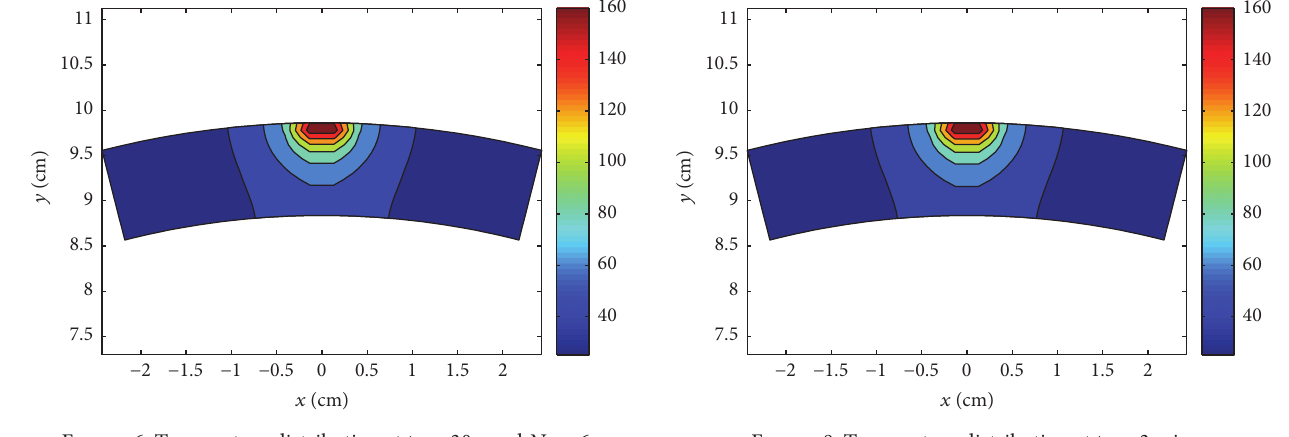
Figure 6: Temperature distribution at 𝑡 𝑓 = 30 s and 𝑁 1 = 6 .